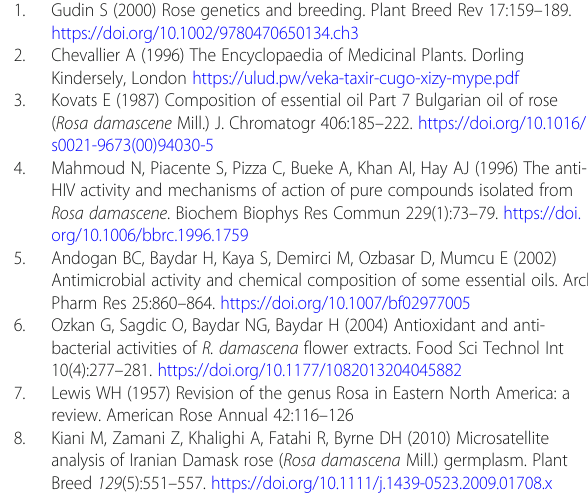
Additional file 1: Supplementary Table1. Genotype classification. Classification of genotypes into different groups according to the figure 2 based on SCoT +URP (C)